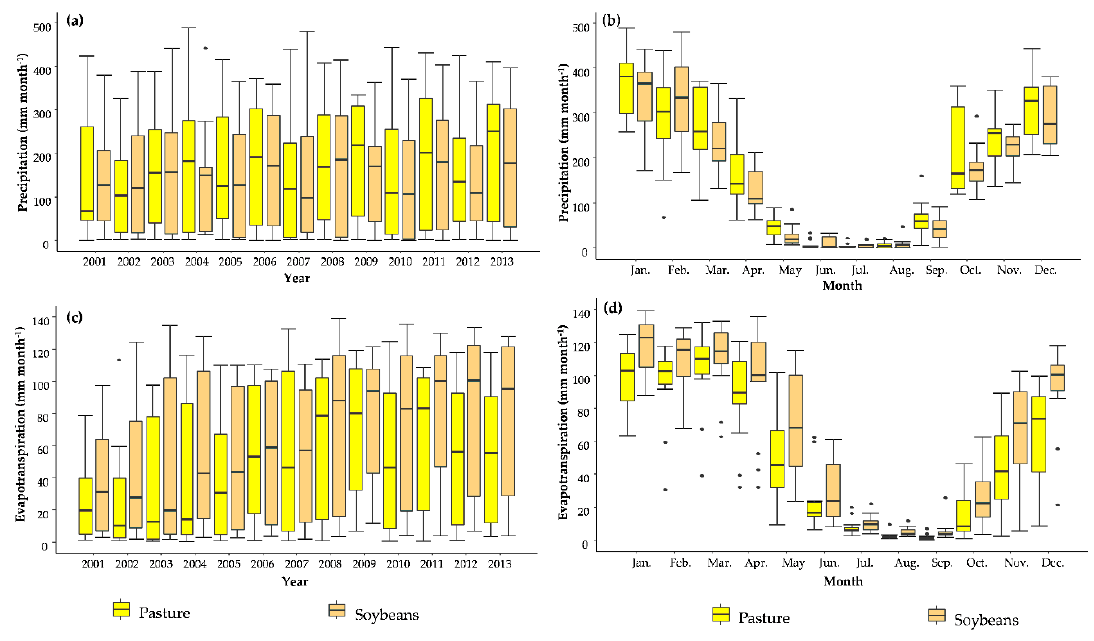
Figure 6. ( a , b ) Interannual / intra-annual boxplots for the monthly average PPT and ( c , d ) interannual / intra-annual boxplots for the monthly average ET in pasture and soybean areas in the Xingu River Basin during the 2001–2013 period.